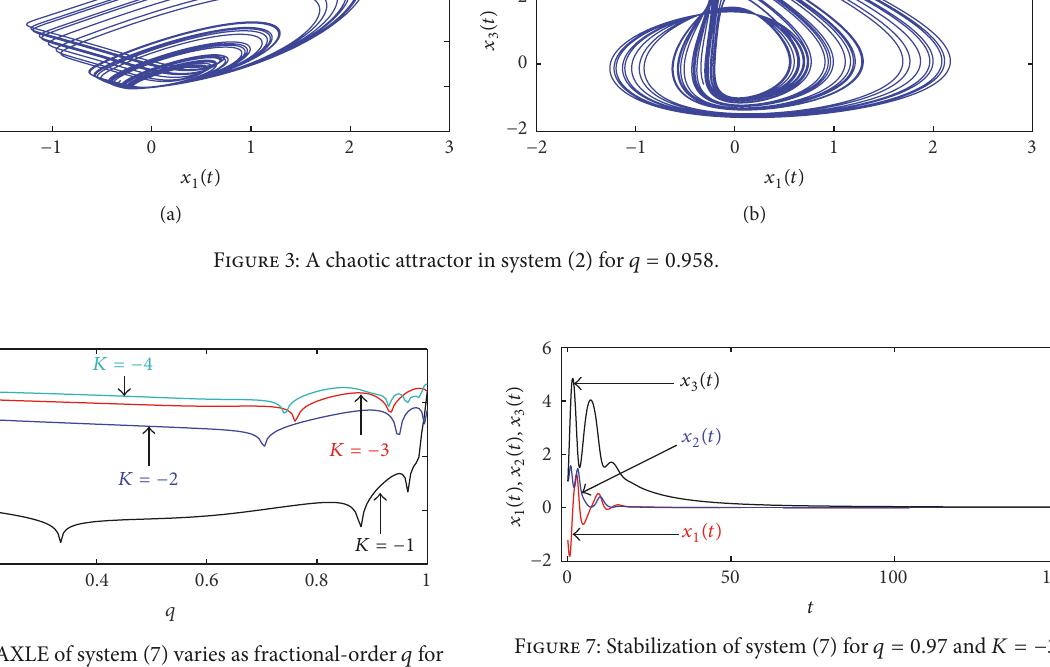
Figure 4: The MAXLE of system (7) varies as fractional-order 𝑞 for some control parameters 𝐾 .